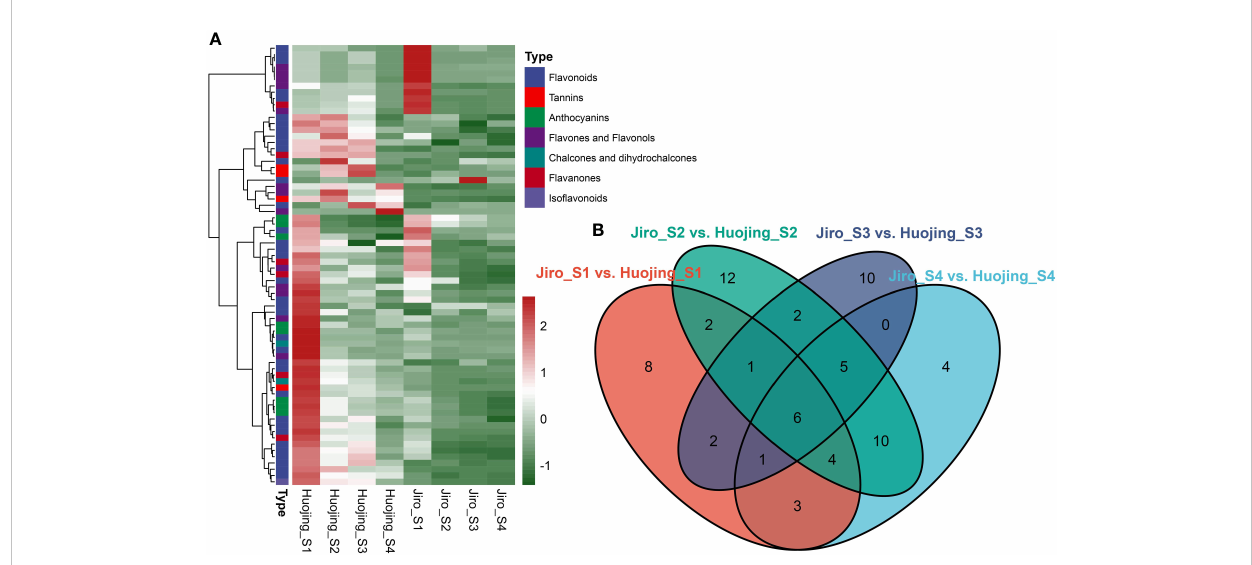
FIGURE 5 Differentially accumulated fl avonoids (DAFs) in ‘ Jiro ’ (PCNA type) and ‘ Huojing ’ (PCA type). (A) Heatmap of the DAFs. The Heatmaps depict the normalized gene expression values, representing the mean value of three biological replicates. (B) Venn diagram of DAFs.